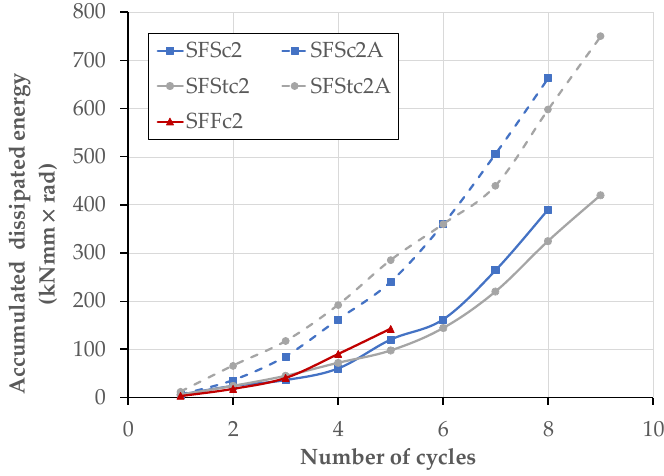
Figure 10. Accumulated dissipated energy of each joint against number of cycles.